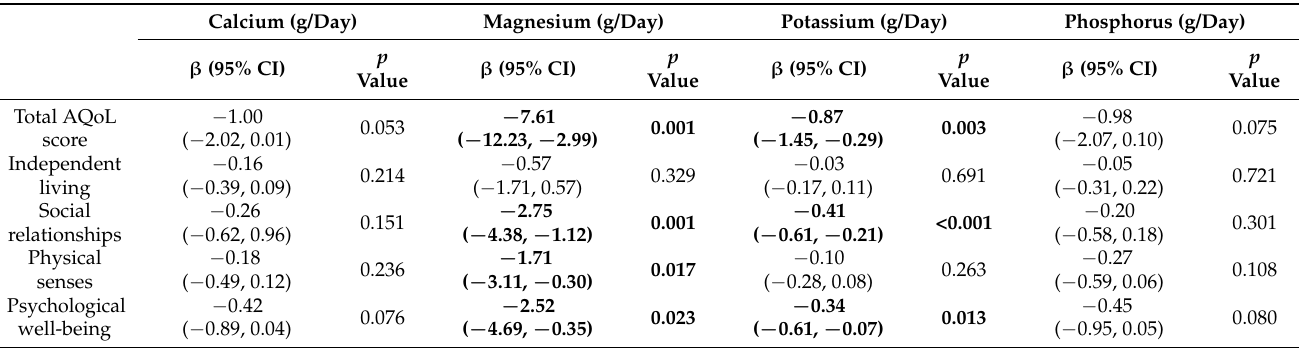
Table 4. Associations of macroelements with AQoL over 2